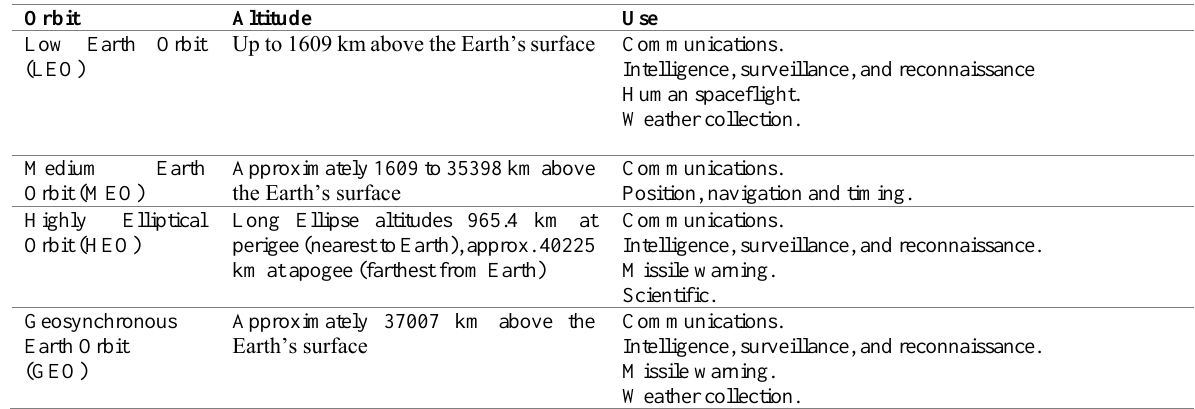
Table 1: The different types of orbits, the altitudes, and the